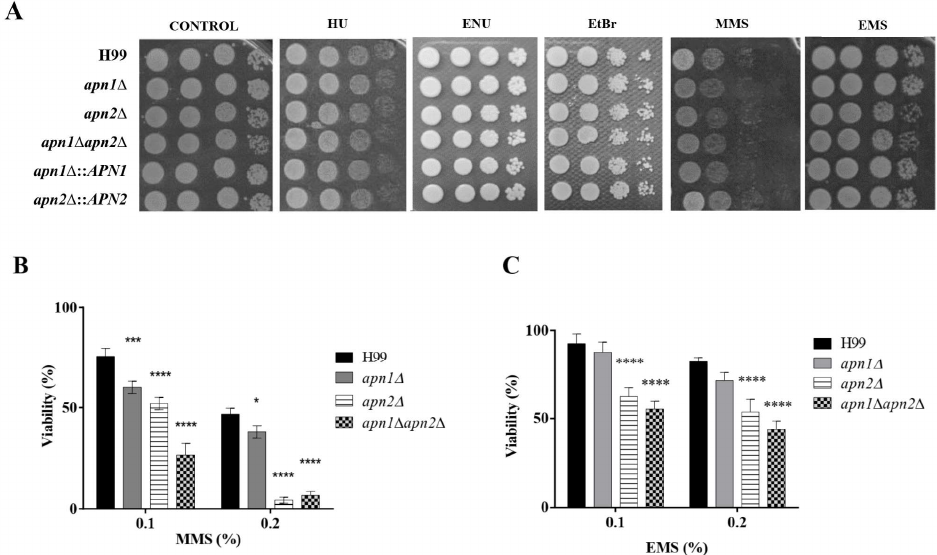
Figure 3. Predicted Apn2 endonuclease is required for yeast viability after exposure to DNA-alkylating agents. ( A ) The different strains were serially diluted ten-fold and plated onto YPD agar supplemented with DNA damage-inducing agents: 0.03% methyl methane-sulfonate (MMS), 0.04% ethyl methane-sulfonate (EMS), 200 µg/mL N-ethyl-N-nitrosourea (ENU), 20 µg/mL ethidium bromide (EtBr) or 110 mM hydroxyurea (HU). The plates were incubated at 30 °C for 48 h. The results are representative of three independent experiments. ( B ) Cell viability after exposure to 0.1 or 0.2% MMS or ( C ) 0.1 or 0.2% EMS. The strains were exposed to the agents in liquid YPD for 1 h, at 30 ◦ C and 150 rpm. Cells were then phosphate-buffer saline- (PBS)-washed and plated on YPD agar for CFU counting. The graphs represent the percentage of viable cells normalized by the percentage of viable control cells. The WT H99 strain was used as control for statistical comparison. One-way ANOVA with Dunnett’s multiple-comparisons test was used to compare the means of results from three independent experiments. Error bars represent standard errors of the mean. **** p < 0.0001; *** p < 0.001; * p < 0.05.